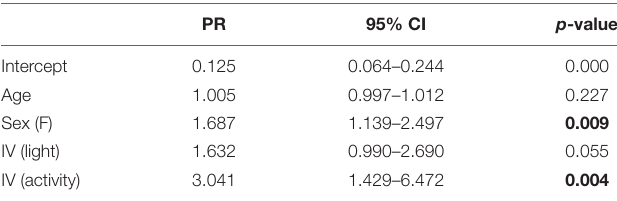
TABLE 3 | Poisson regression (model 2): variables derived from actimetry associated to overweight or obesity ( N = 121). PR 95% CI p